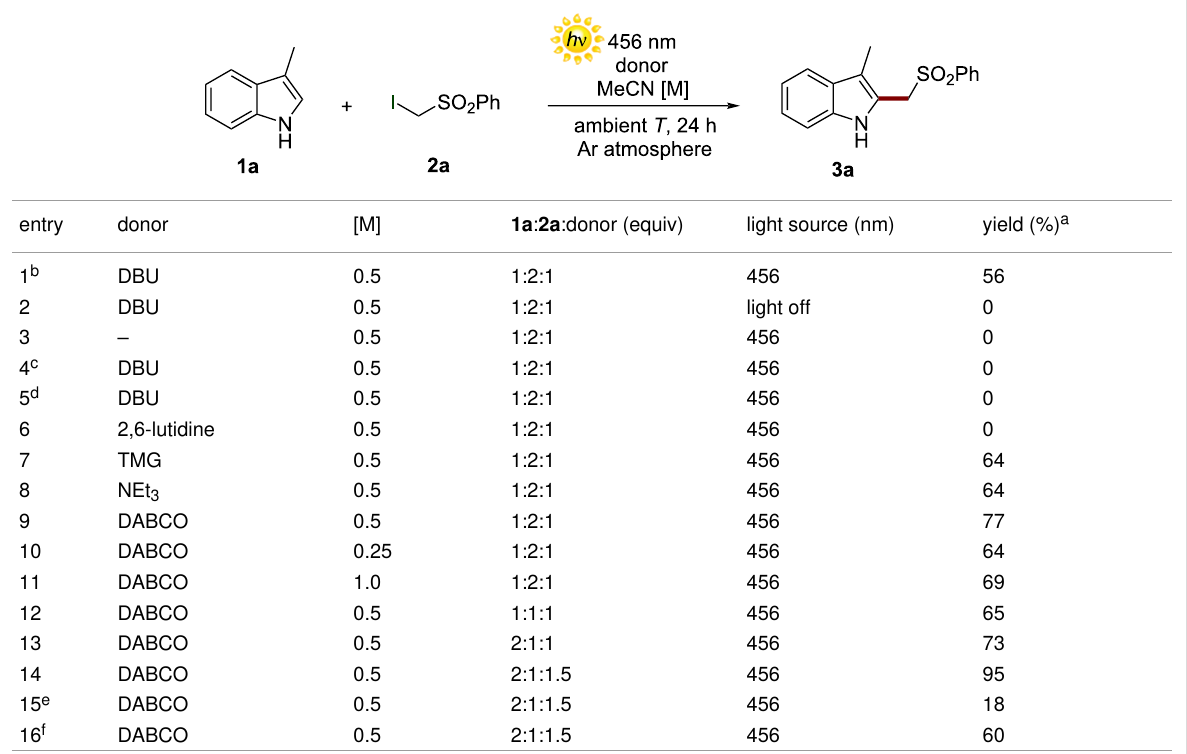
Table 1: Optimization of the reaction conditions and control